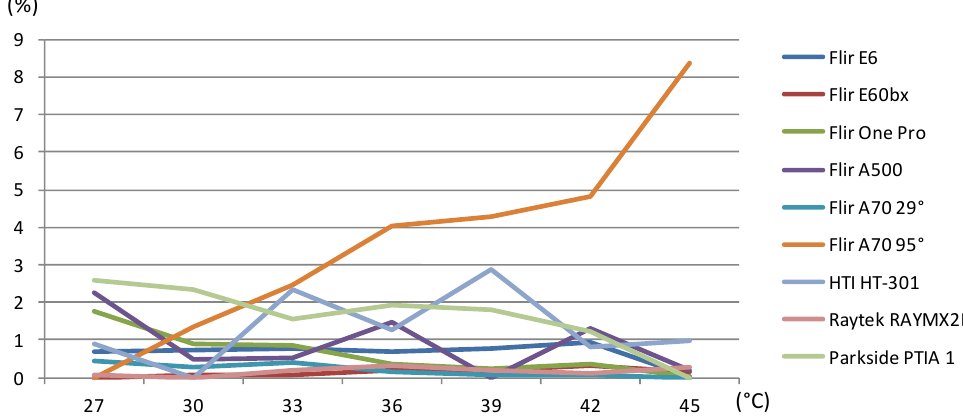
Figure 26. Percentage deviation from the mean deviation for individual cameras.